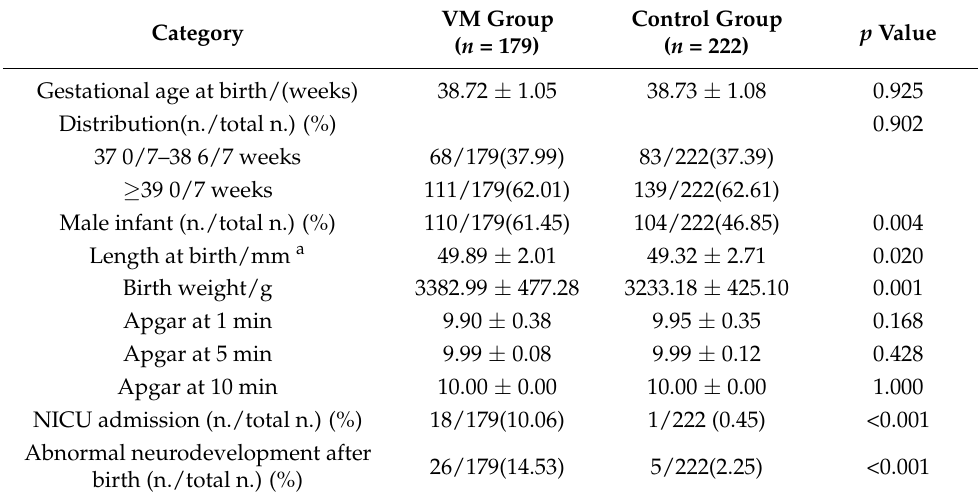
Table 2. Short-term and long-term outcomes of the VM group and control